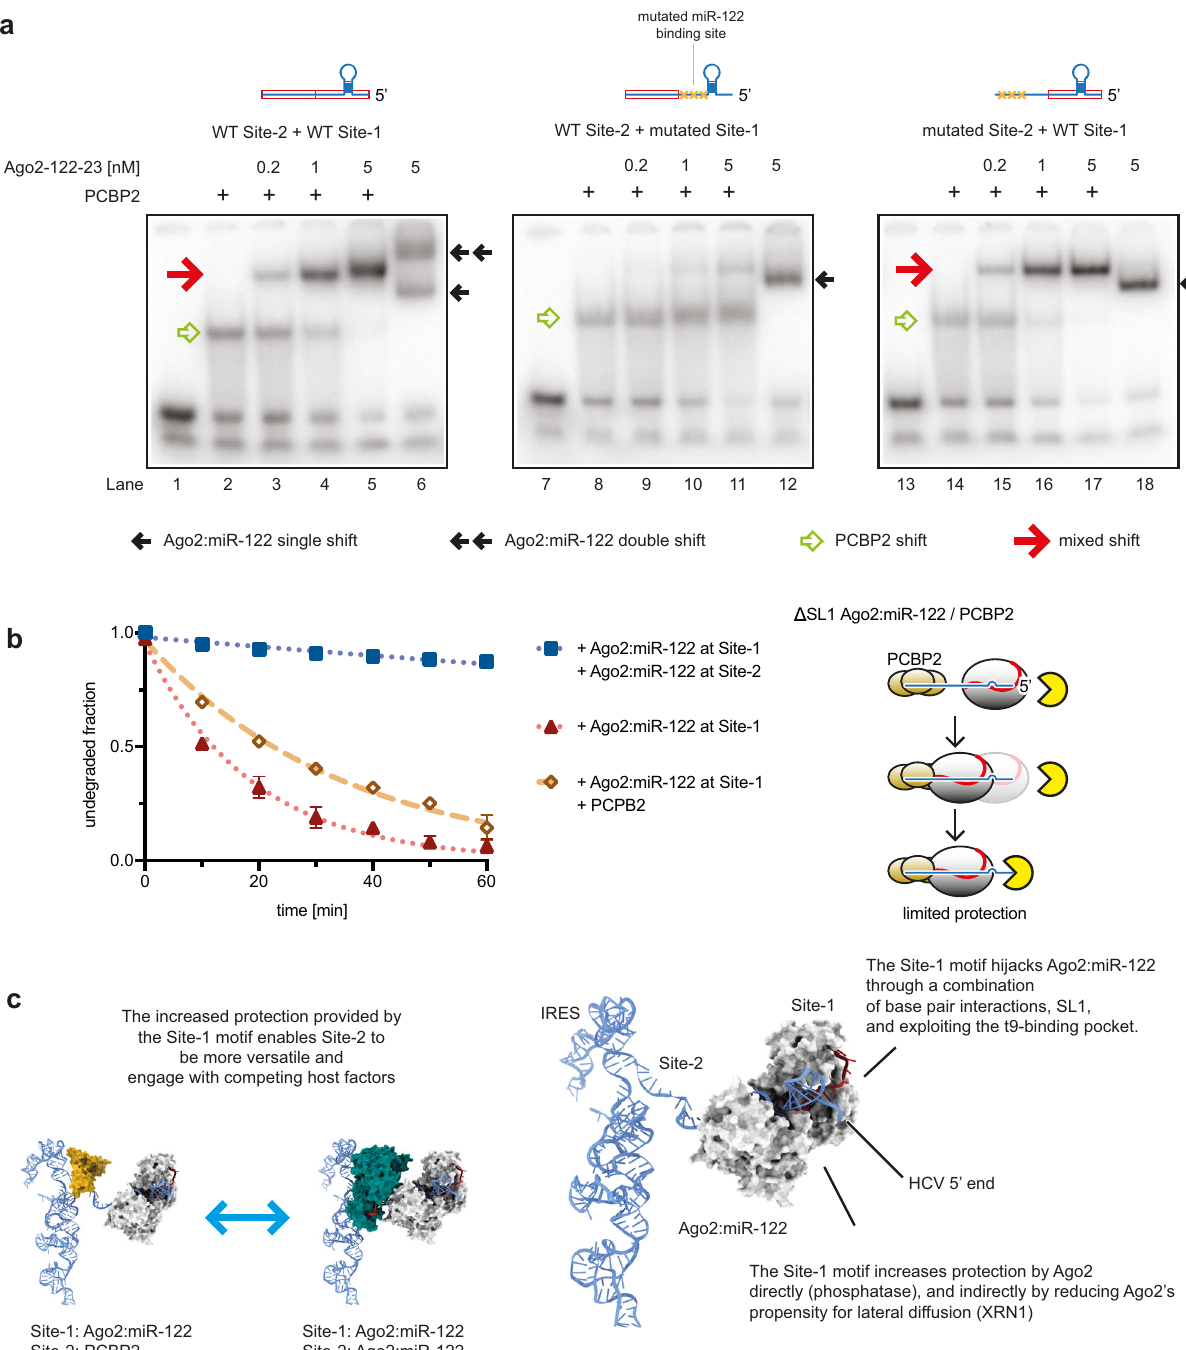
Fig. 5 A mixed Ago2:miR-122:PCBP2 complex can form on the HCV 5 ’ tail. a EMSA of HCV 5 ’ tail RNAs by PCBP2 and/or Ago2:miR-122. WT, MUT1, and MUT2 RNAs were incubated with PCBP2 (100 nM), and/or Ago2:miR-122 (concentrations indicated), or both prior to running the gel. Lanes 1, 7, and 13 show free RNA for WT, MUT1, or MUT2. Schematic of HCV 5 ’ tail RNAs (blue) with miR-122 binding sites as red boxes and mutated sites indicated by orange X ’ s, show at the top. The experiment was repeated twice and a representative gel is shown. b XRN1 mediated degradation of Site-1 Δ SL1 MUT2 RNA in presence of Ago2:miR-122-wt, Ago2:miR-122-wt and PCBP2, or Ago2:miR-122-wt and -mut. Data shown as means of 3 independent replicates with error bars representing SEM. The cartoon (right) describes the proposed mechanism, with PCBP2 occupancy at Site-2 only partially reducing Ago2:miR-122 lateral diffusion from Site-1. c Model of Ago2:miR-122 bound to Site-1 with HCV IRES shown for scale (PDBID: 5a2q). Ago2 occupancy at Site-1 may enable a molecular switch in which Site-2 occupancy alternates between Ago2:miR-122 and PCBP2 (represented as 3 KH domains, PDBID: